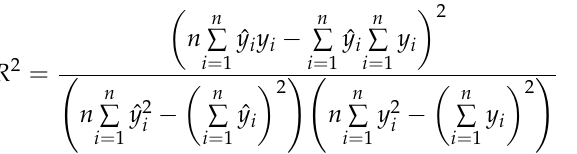
Figure 15. Correlation analysis diagram of training set model.